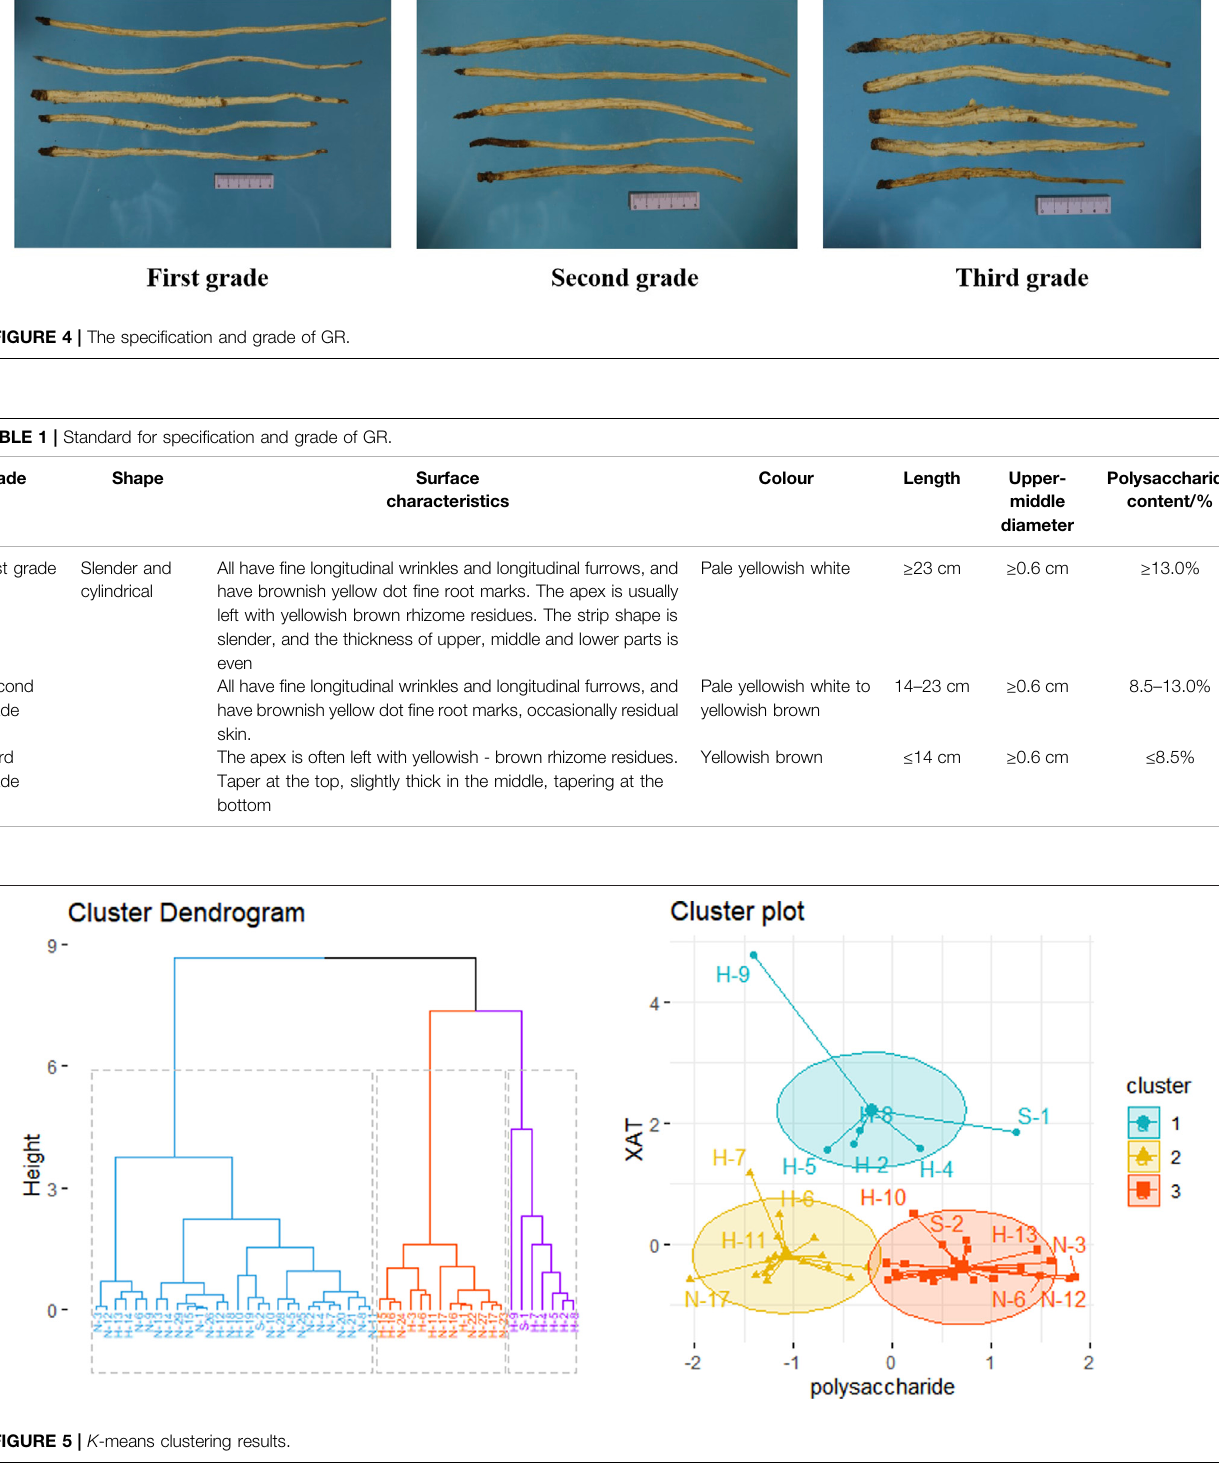
FIGURE 5 | K -means clustering